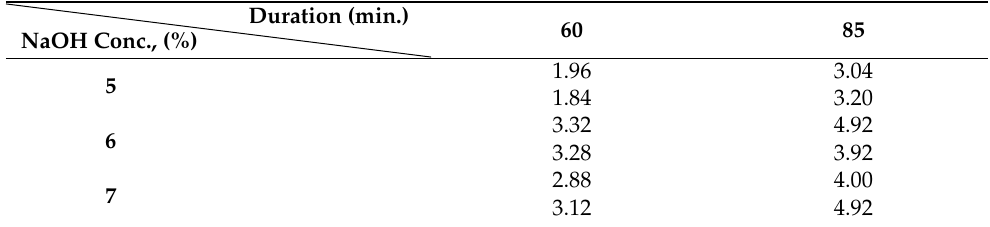
Table 2. Yields values for the supplementary 2 2 experimental plan for the deproteinization tempera- ture of 90 ◦